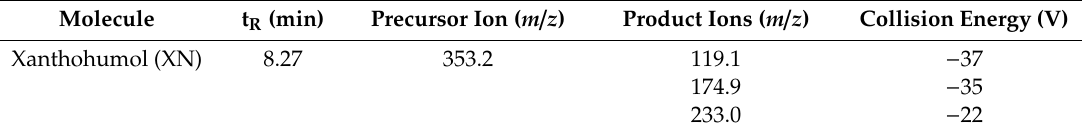
Table 7. Retention time and MS / MS parameters for the identification of XN in negative